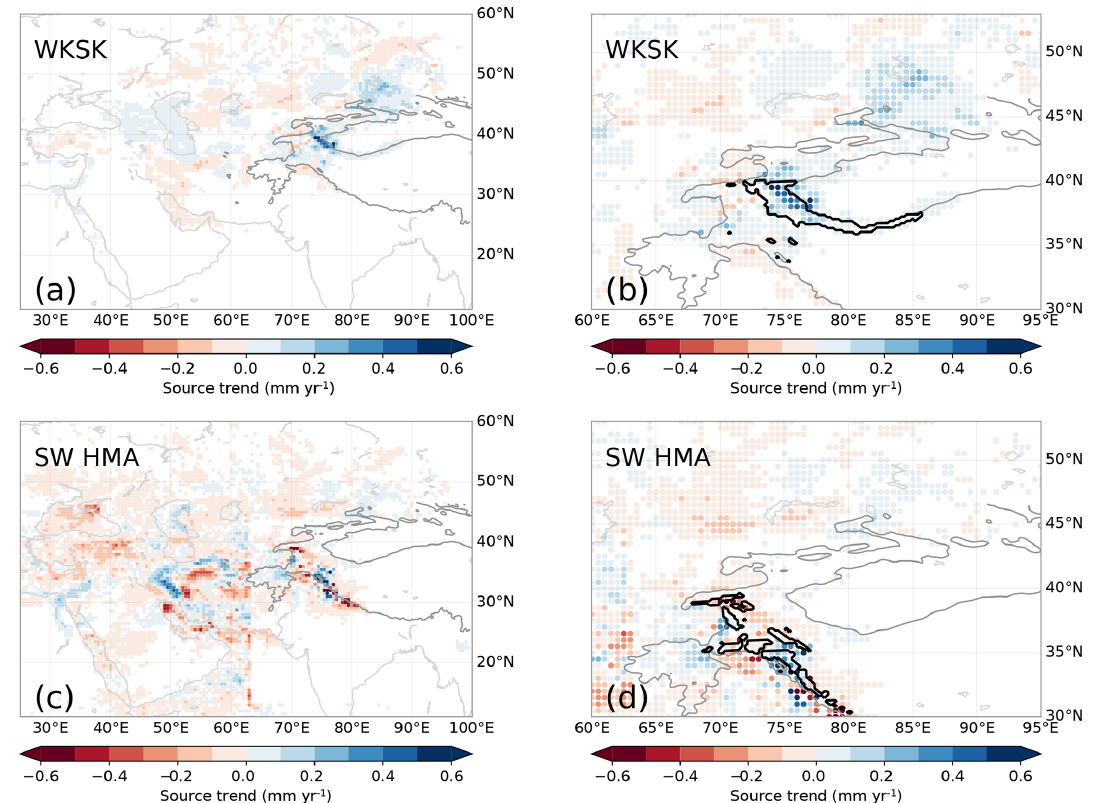
Figure 14. Trends in the amount of moisture from a given source contributing to precipitation trends in the target area (a, c) , with a detailed view (b, d) around the target area from which the parcels were released (contoured in bold) for the WKSK (a, b) and south-western HMA (c, d) . Trends with absolute magnitudes smaller than 0.02mmyr − 1 are made white. The 2000m elevation contour in the WRF domain is indicated by a solid